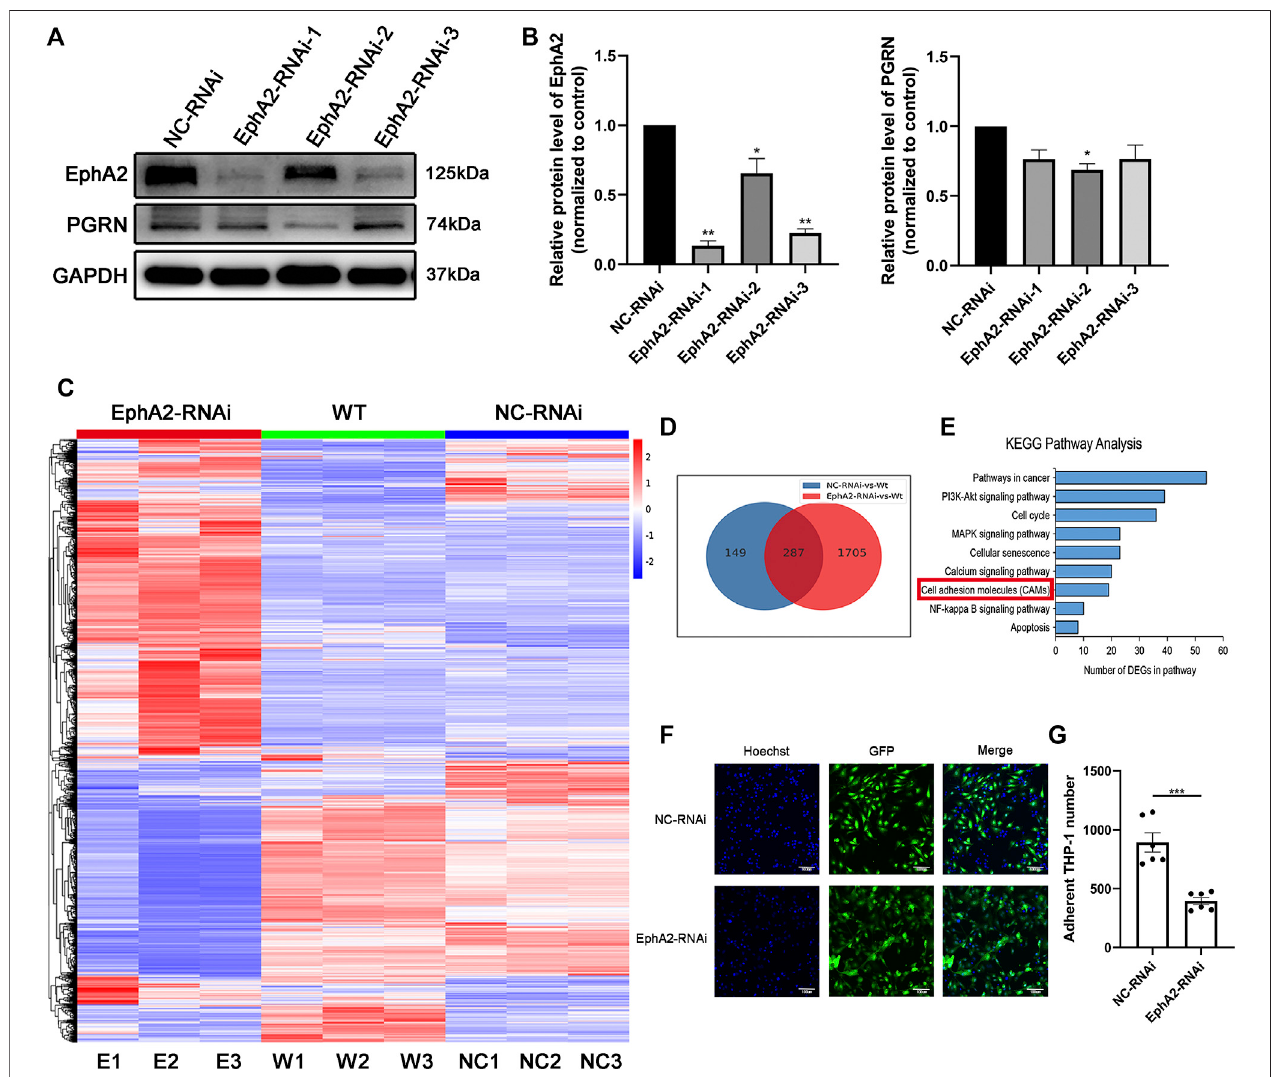
FIGURE 2 | EphA2 knockdown suppressed cell adhesion molecule expression in HUVECs. (A,B) Western blotting results showed an ef fi cient knockdown of EphA2 expression in HUVECs with different interference sequences (labeled as EphA2-RNAi-1, -2, -3) (C) Heat map of mRNA changes in EphA2-RNAi, NC-RNAi, and WT group by the bulk RNA-seq. (D) Venn diagrams depicted a total of 287 common differential genes in EphA2-RNAi cells vs. WT cells and NC-RNAi cells vs. WT cells (E) KEGG pathway assay of differential mRNA transcripts in EphA2-RNAi HUVECs identi fi ed by the RNA-seq. (F) THP-1 (blue, stained by Hoechst 33,342) monocyteadhesioninEphA2knockdownHUVECs(GFP-labeled,green). (G) ComparisonofadherentTHP-1numberbetweenEphA2-RNAigroupandNC-RNAigroup in HUVECs. Data are presented as means ± SEM (* p < 0.05, ** p < 0.01, *** p < 0.001 vs. NC-RNAi group, ANOVA, n (cid:1) 3 or 6). Scale bar: 100 μ m. WT: wild-type. NC: negative